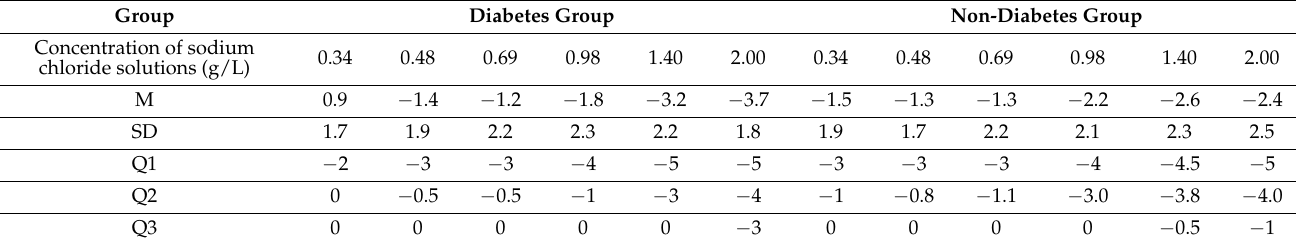
Table 9. Hedonic assessment of sodium chloride solutions by